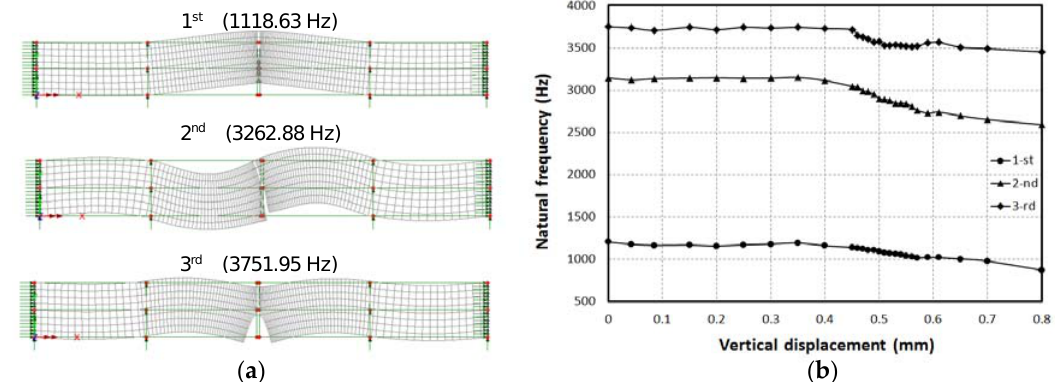
Figure 9. Test 1: ( a ) first three numerical (FEM) bending modes and related frequencies (unloaded beam, initial notch depth) and ( b ) experimental natural frequencies vs. displacement curves.